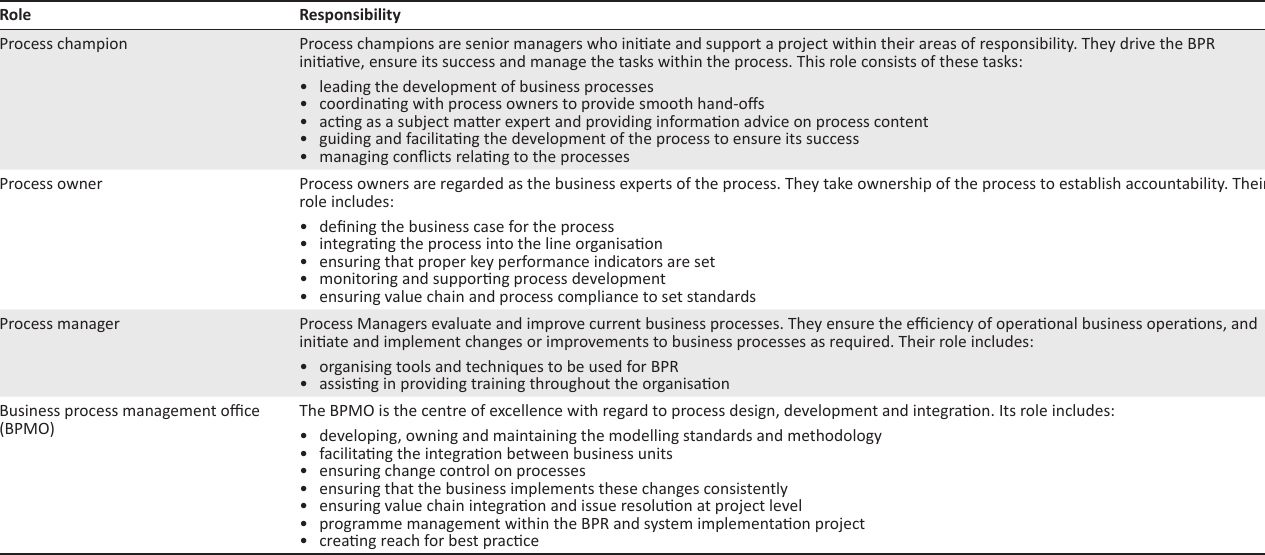
TABLE 1: Business process re-engineering experts’ roles and responsibilities. Role Responsibility Process